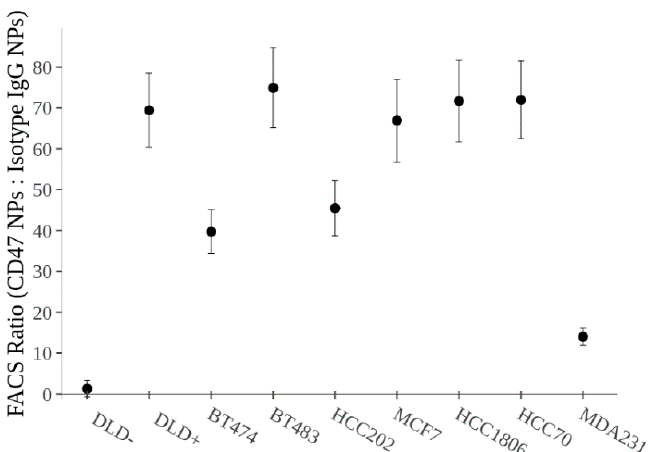
Figure 4. FACS data showing the ratio of CD47 labeled SERS NPs to Isotype IgG labeled SERS NPs. This data reveals the specific binding of our CD47 SERS NPs to each of the cell lines. The Isotype NPs are acting as a control to reveal non-specific binding of the NPs to the cell surface. Note the significant difference ( p < 0.01) between the negatively CD47 expressing cell line, DLD − , and the rest of the cell lines.